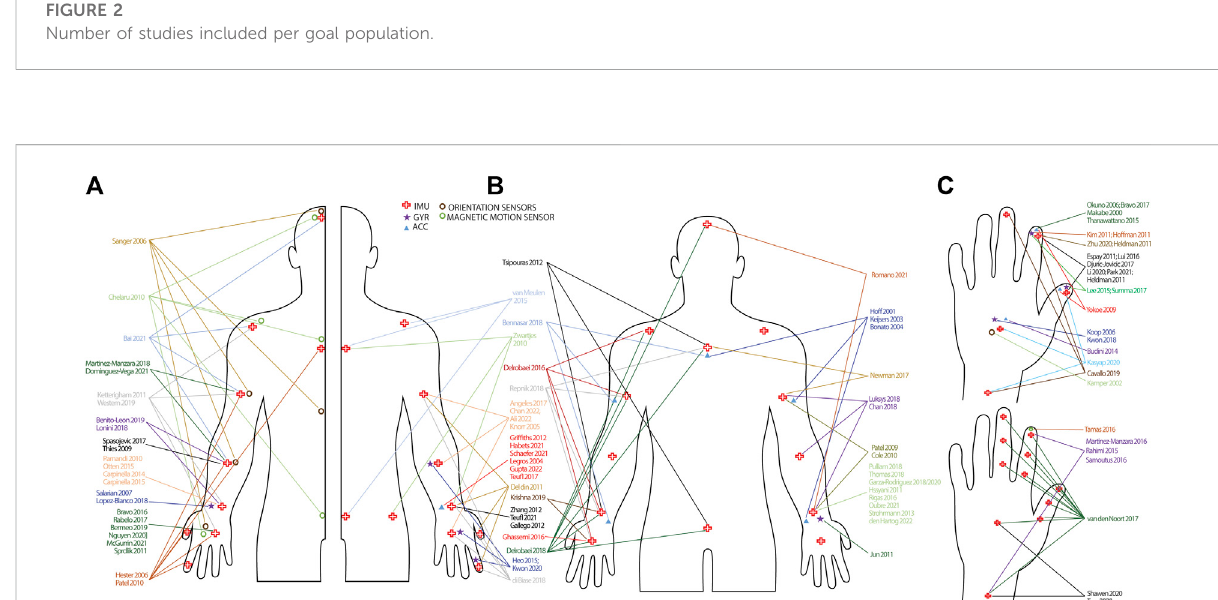
FIGURE 3 Infographic of sensor types and set-up. (A) : Studies including a unilateral sensor-set-up. Studies are randomly split in left and right side of the body to improve interpretation. (B) : Studies including a bilateral sensor set-up. Arrows have not been drawn to the contralateral side of the body to improve interpretation. (C) : Sensor placement on the hand and wrist. Hands are randomly split to improve interpretation. Sensor placements on the lower limb are not presented, but can be found in Supplementary Table S1. IMU = inertial measurement unit; GYR = gyroscope; ACC =